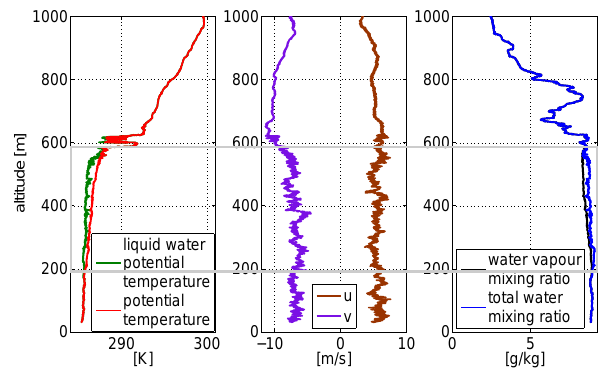
Fig. 2. Vertical profiles of potential temperatures, components of horizontal wind, and mixing ratios characteristic for research flight TO10. Cloud layer marked with a gray box.